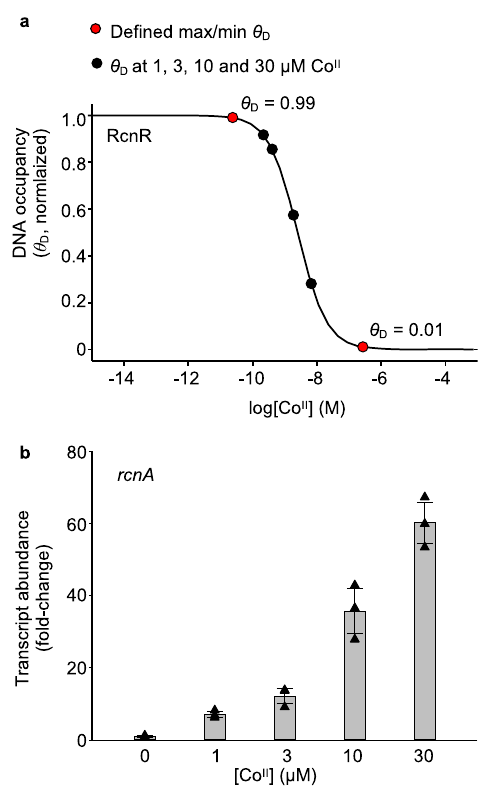
Fig. 8 Calculations of conditional Co II availabilities in B 12 -producing E. coli* . a Calculated relationship between intracellular Co II availability and normalised DNA occupancy ( θ D ) by RcnR. θ D of 0 and 1 are the maximum and minimum calculated DNA occupancies. The dynamic range